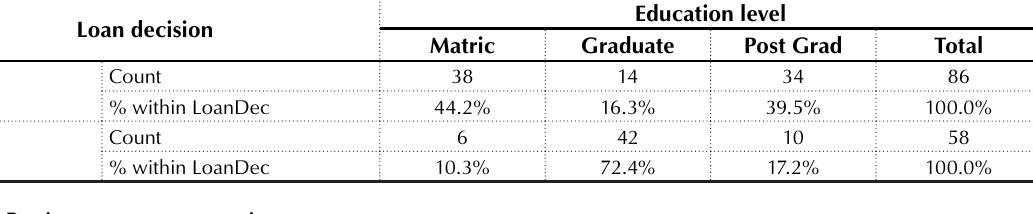
Table 4. Business owner experience